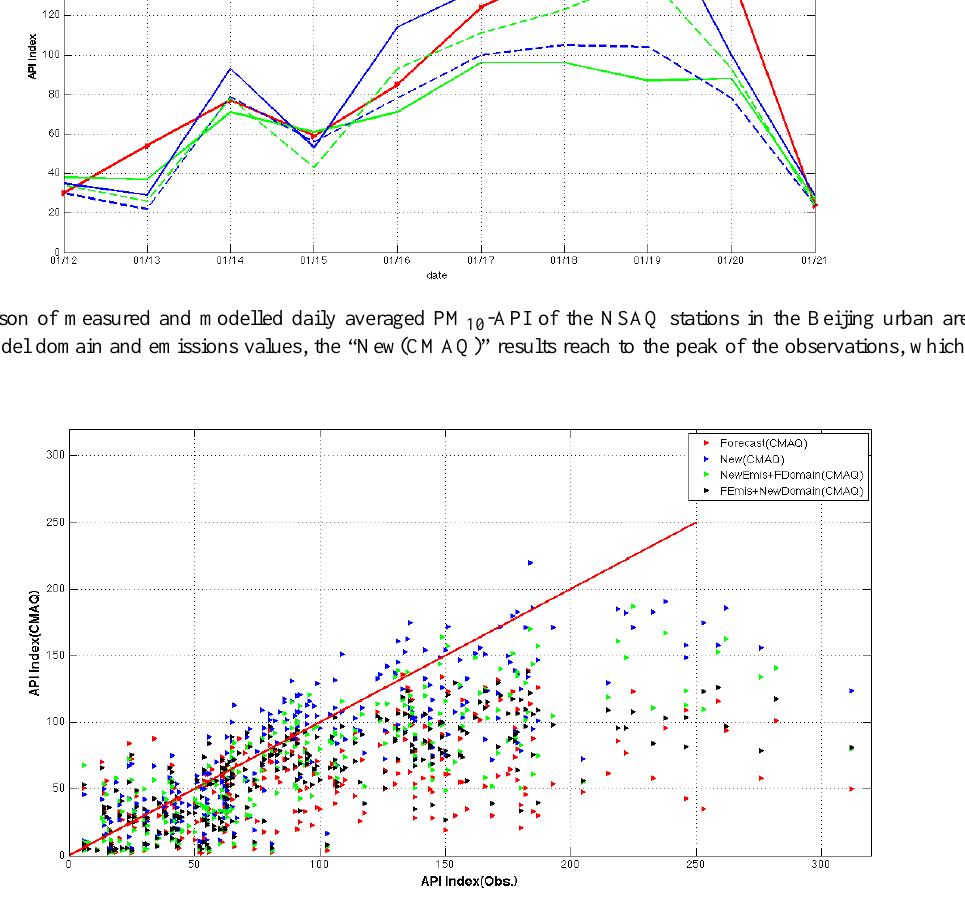
Figure 8. Scatter diagram of the observed and simulated PM 10 -API of all stations in Beijing. Red indicates the original forecast results, and the blue triangles show the final model results, which are driven by the updated emissions in the expanded model domain, marked as